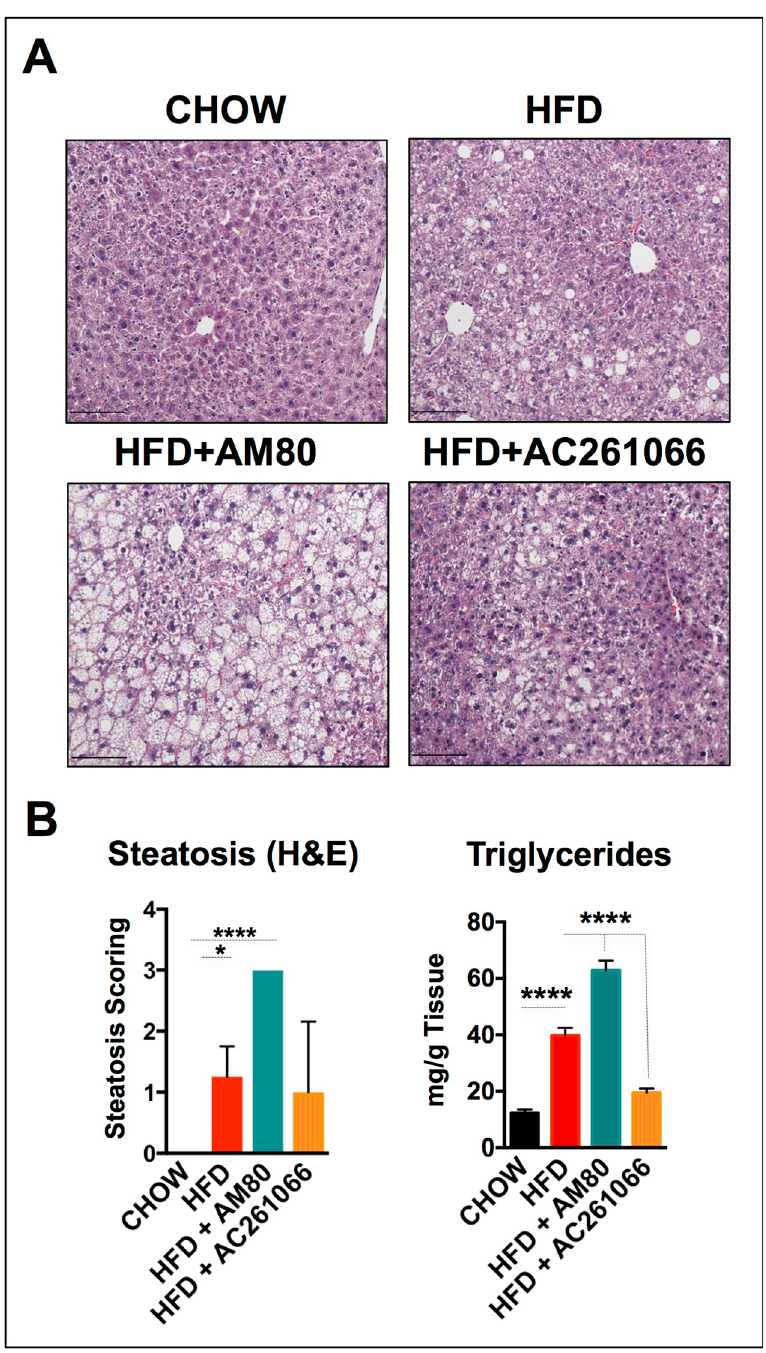
Fig 4. The RAR α -synthetic agonist AM80 increases steatosis in HFD-fed mice. (A) Representative images of hematoxilin and eosin (H&E)-stained liver sections in chow-fed and HFD-, HFD+AM80-, and HFD +AC261066-treated mice. ( B ) Scoring of steatosis was assessed according to the Brunt criteria (details in the methods) in the H&E images (4 mice per group) and lipid accumulation by Folch extraction (triglycerides) (4 mice per group). The plots are represented as mean ± standard deviation (SD). Statistical significance is assessed by one-way ANOVA (black stars), p � 0.05 = � ; p � 0.0001 = ���� . Magnification 200X. Scale bar = 100 μ m.